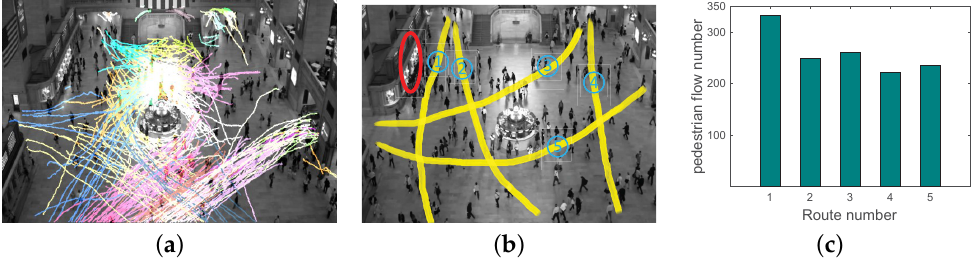
Figure 6. The statistics in New York Grand Central Station. ( a ) Trajectory clustering; ( b ) The extracted trajectories; ( c ) The pedestrian flow